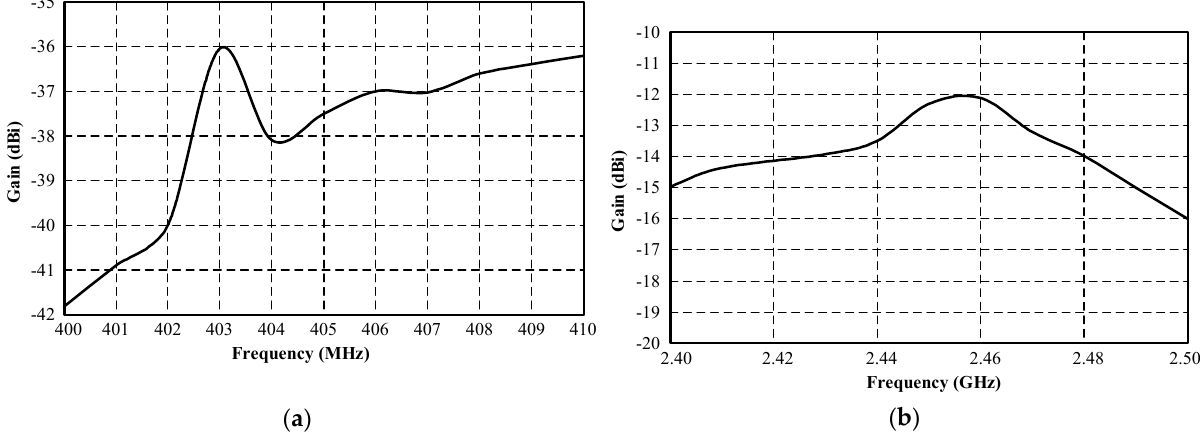
Figure 6. Simulated gain of MICS/ISM meander-line microstrip antenna encapsulated in a glass pod inside the muscular cubicle: ( a ) MICS and ( b ) ISM bands.